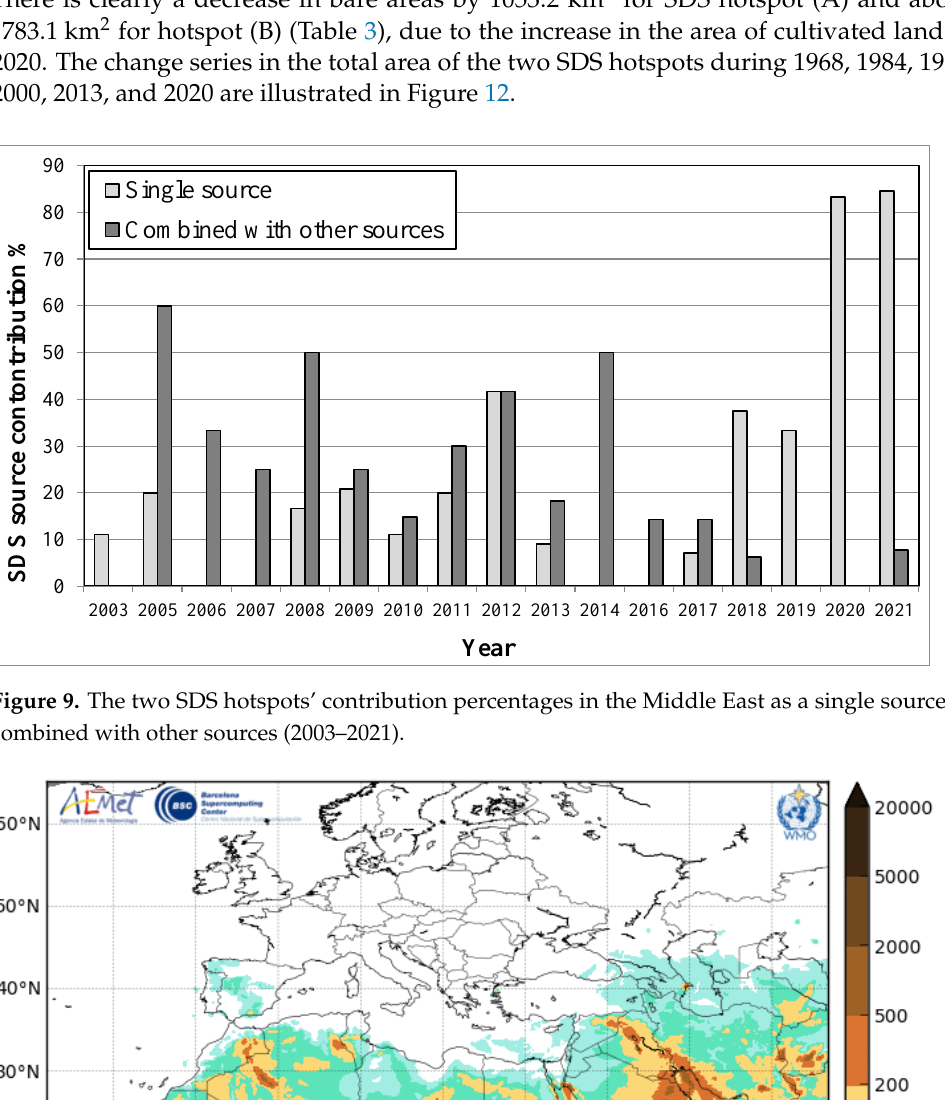
Figure 8. Kuwait annual deposited dust amounts in (tons/km 2 ) for two years from the 1st of Sep- tember to the 31st of August ( a , b ).